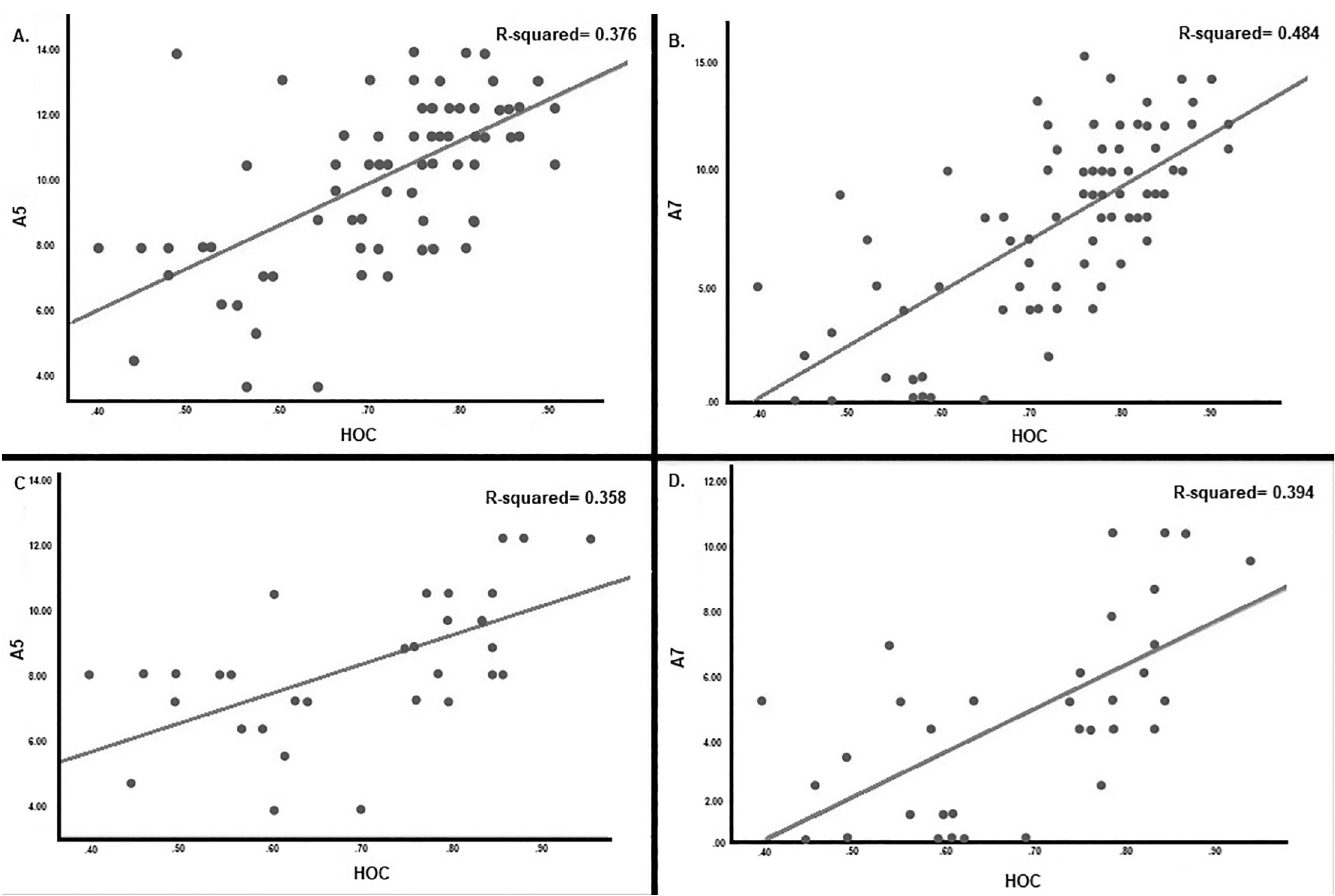
Fig 1. Partial correlations between RAVLT and HOC for the whole sample (A and B) and MCI+DAD (C and